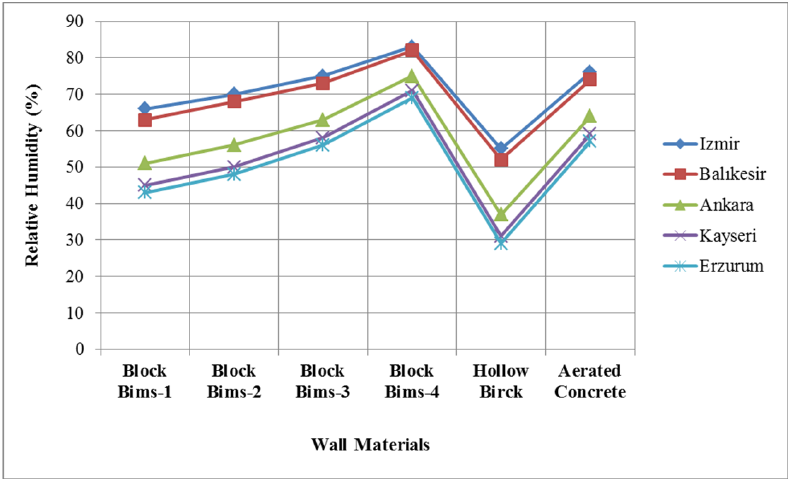
Figure 9. Relative humidity values required for mold that may occur indoors due to different wall materials’ uninsulation.